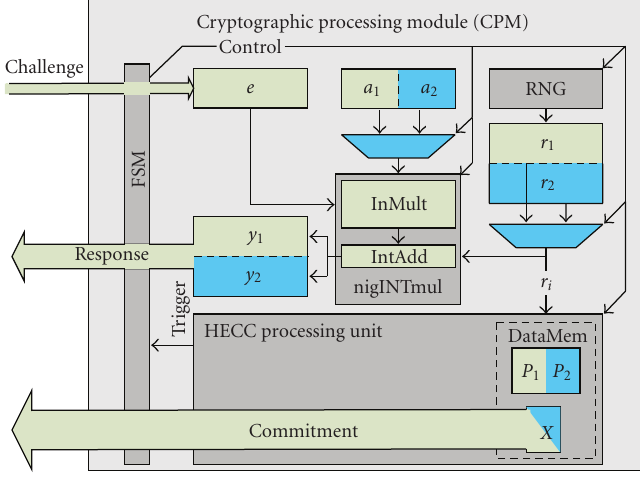
Figure 4: Cryptographic processing module (CPM).